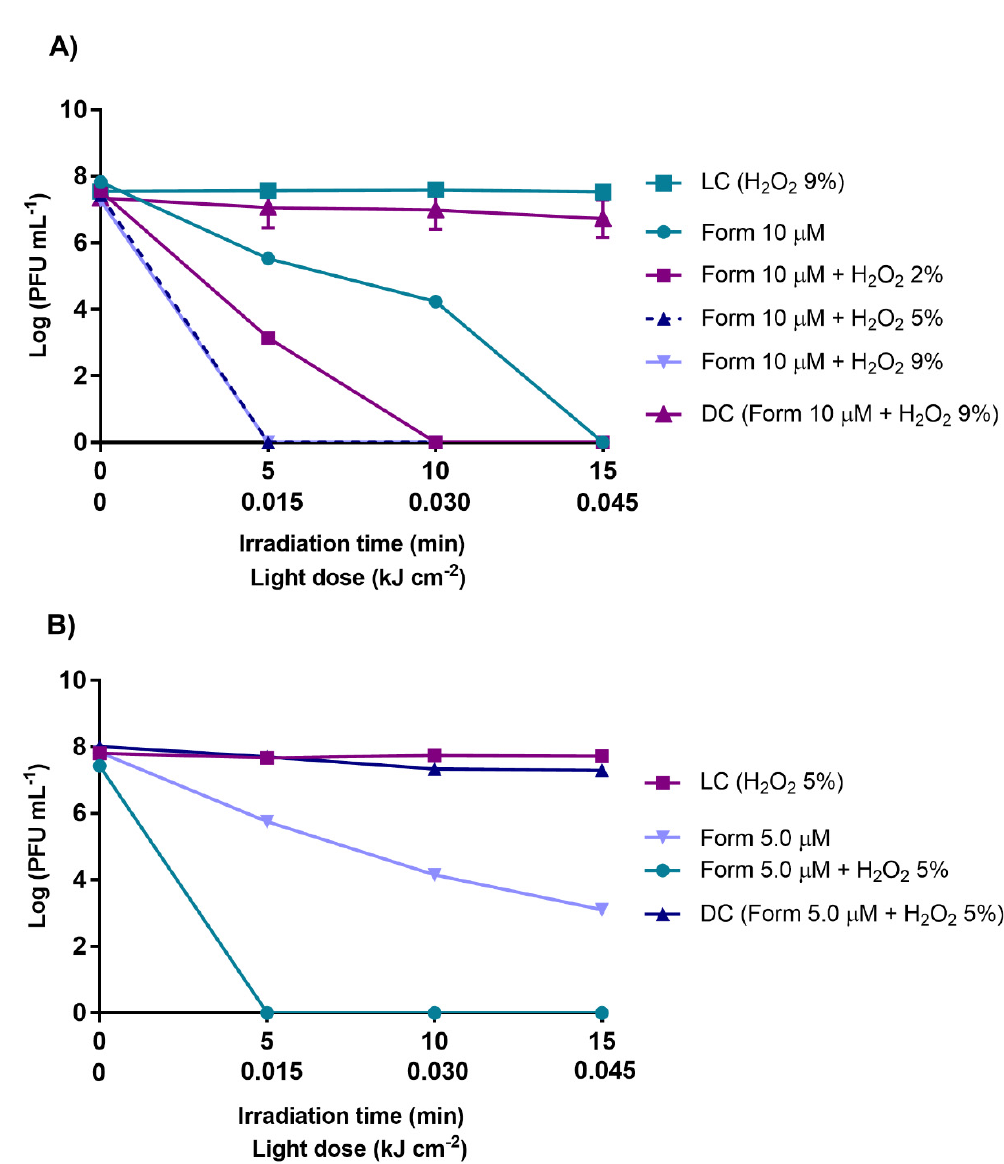
Figure 5. Inactivation of T4-like bacteriophage during aPDT, in non-filtered WW with Form at 10 µM alone and in combination with H 2 O 2 (2, 5, and 9%) ( A ), and Form at 5.0 µM alone and in combination with H 2 O 2 (at 5%) ( B ), during 15 min of irradiation with white light (50 mW cm − 2 ). The values are expressed as the mean of three independent experiments; error bars represent the standard deviation (SD) between the experiments. In some cases, SD bars are covered behind the symbols and the lines just join the experimental points.